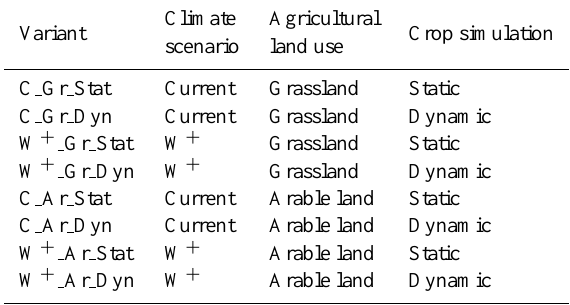
Table 3. Investigated variants of climate and land-use scenarios without/with dynamically simulated crop